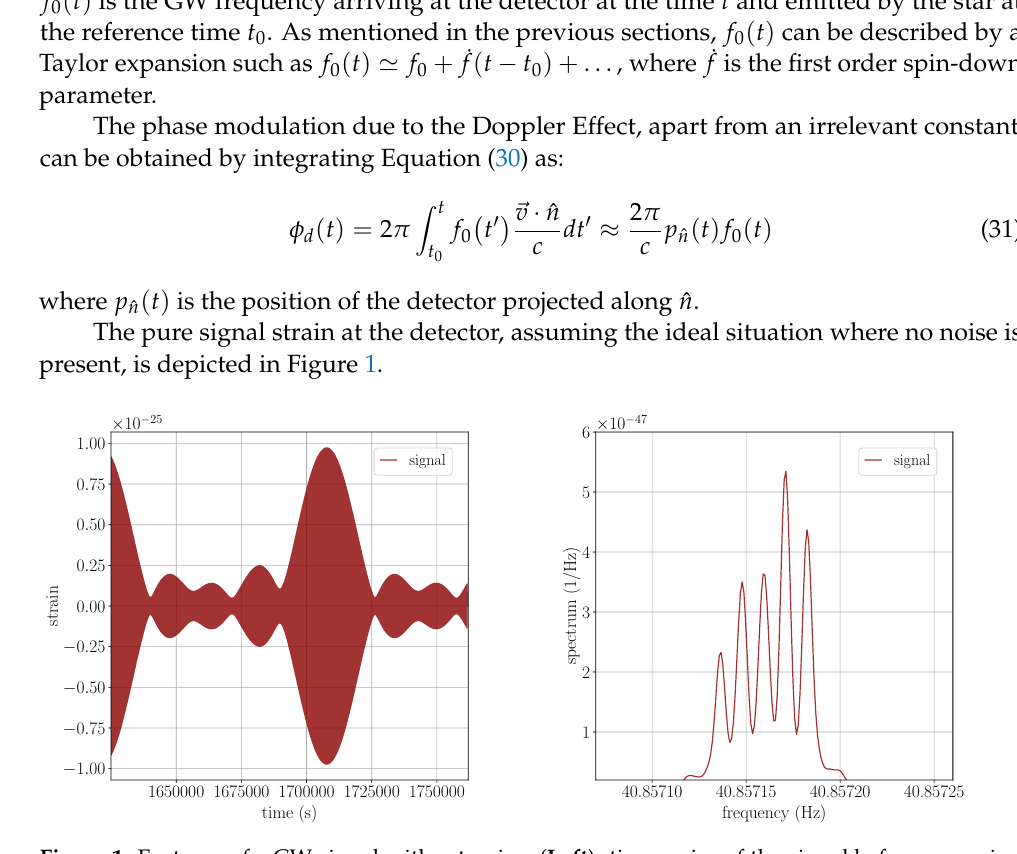
Figure 1. Features of a CW signal without noise. ( Left ): time series of the signal before removing any modulation, the signal is modulated in amplitude and frequency. ( Right ): power spectrum after removing the frequency modulations, the five peaks due to the sidereal modulation are clearly